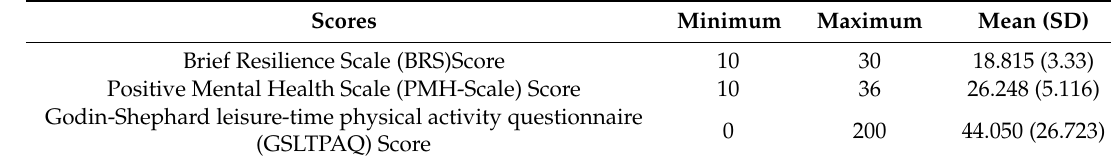
Table 2. Scores on the resilience, positive mental health, and physical activities ( n = 416).